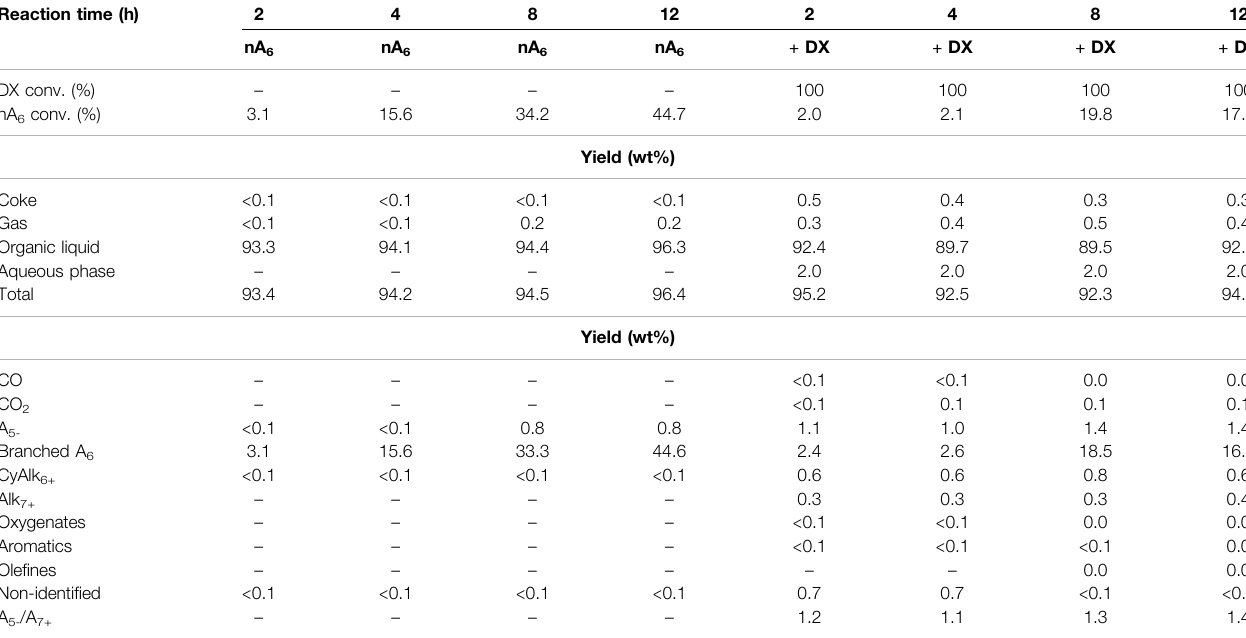
TABLE 5 | Effect of reaction time on DX HDO product distribution and yield (wt%). Conditions: 250 ° C; 30 bar of H 2 ; 90 g n-hexane; 5 g DX; 10 g Cat; catalyst/DX (cid:1) 2/1. Reaction time (h)